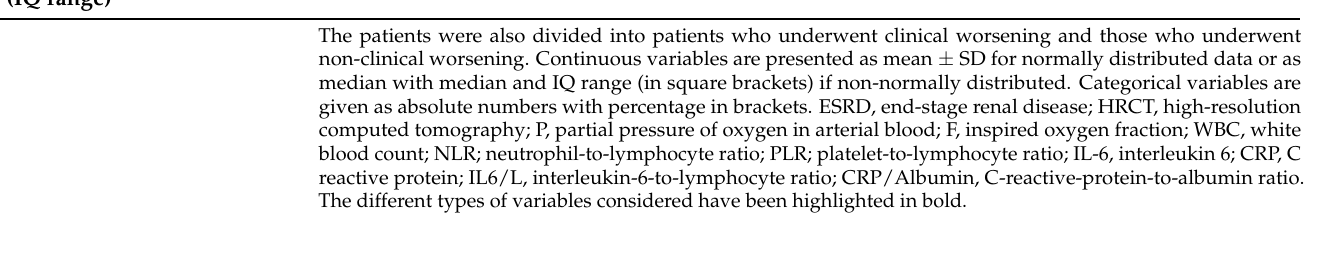
Table 2. Baseline characteristics of CHD patients affected by SARS-CoV-2 pneumonia and divided into patients who survived and